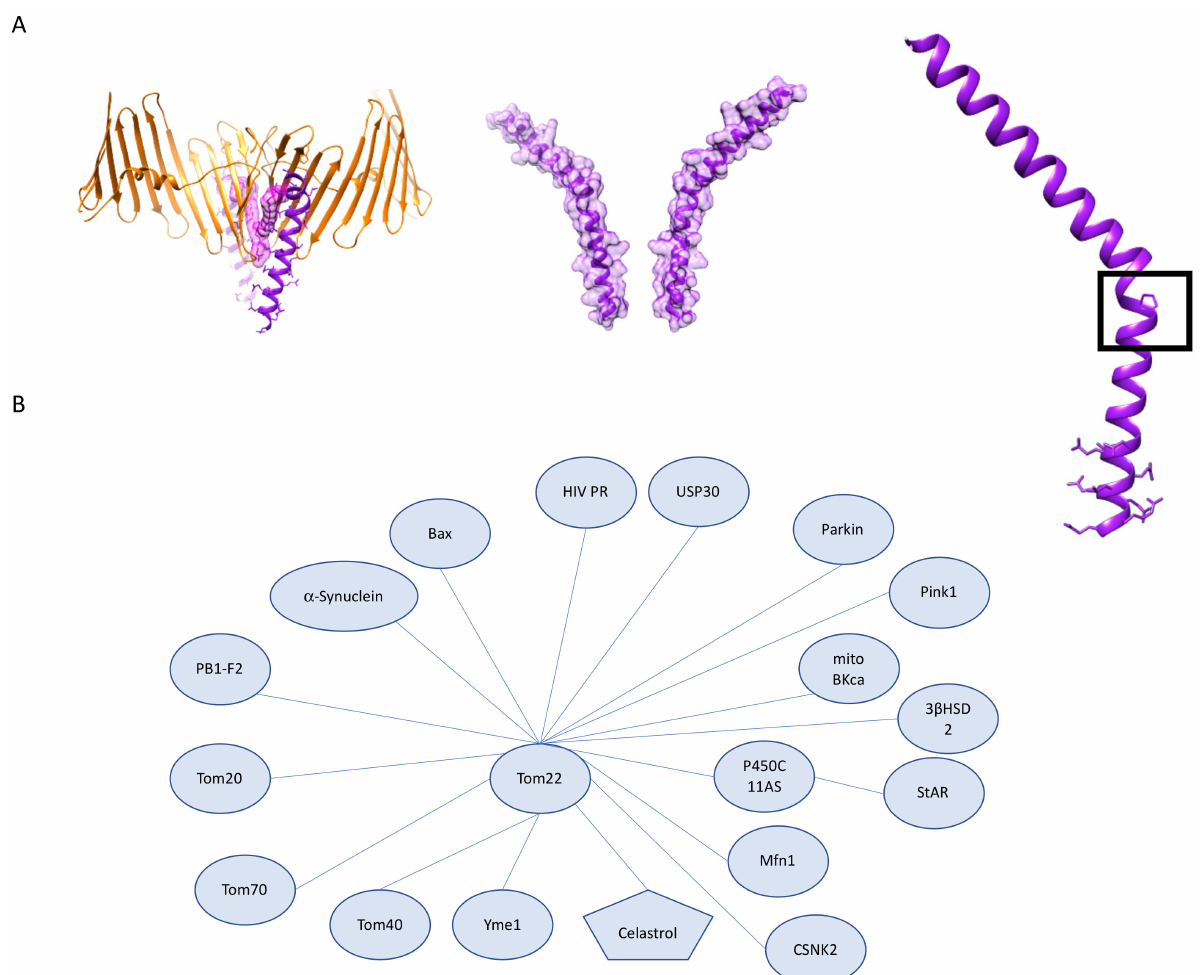
Figure 5. Tom22 structural features and interactome. ( A ) Structure of human Tom22 (PDB:7ck6). ( left ) Tom22 interactions with lipid (magenta, space-filling model) and Tom40 β -barrel exterior. ( middle ) Tom22 dimer (space-filling model). ( right ) Proline responsible for Tom22 kink shown in black box as well as the Q rich C terminal motif. ( B ) Tom22 interactions as described. Distances do not represent interaction